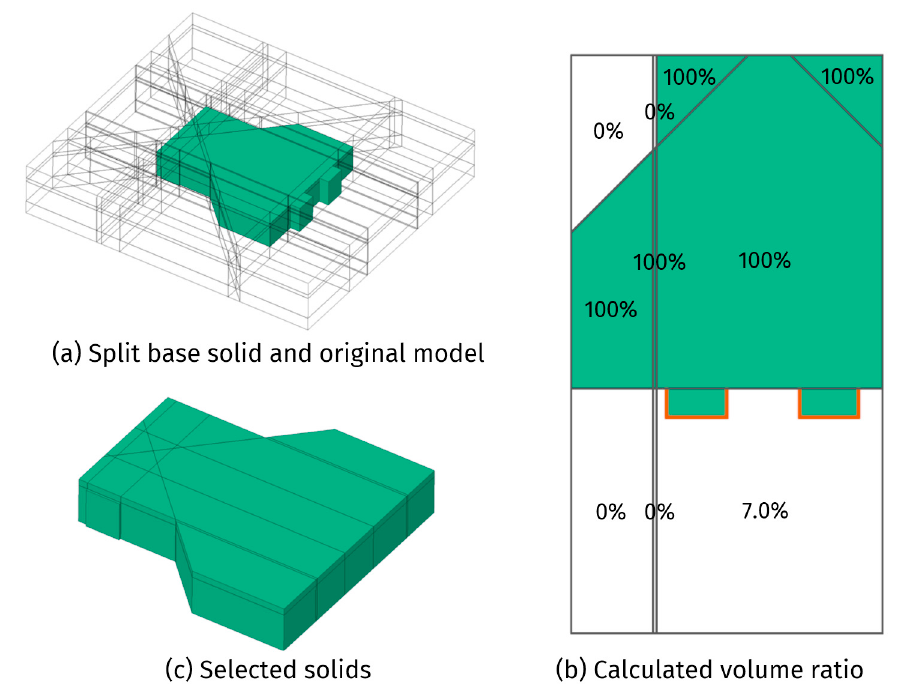
Figure 5. Selection process of split solids. Algorithm 2 Pseudocode for polyhedron generation